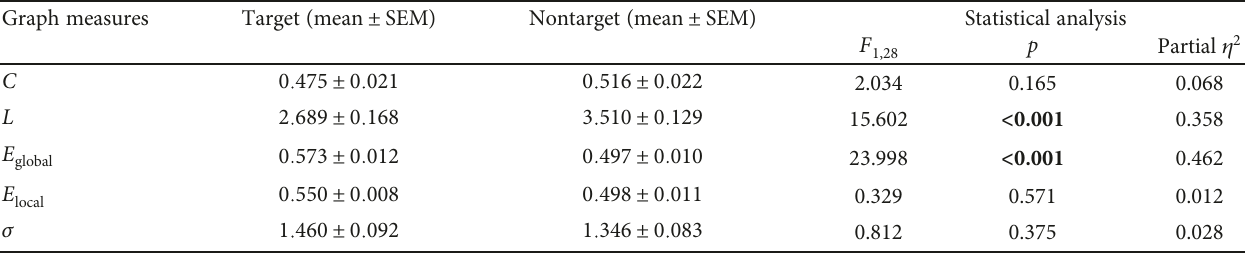
Table 2: Comparisons of the graph measures between target and nontarget condition based on the OMST method. Graph